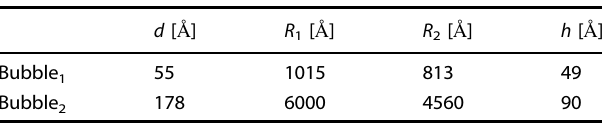
Parameter d denotes the thickness of the few layer ZrTe 5 , R 1 and R 2 are the major and minor semi-axis and h is the height of the bubble. All parameters are in the units of Å.